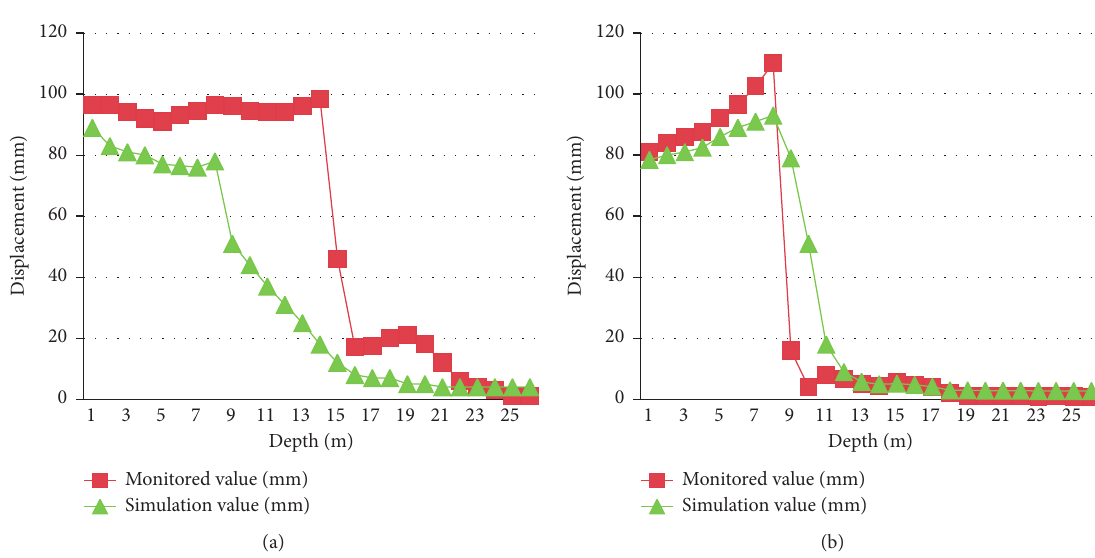
Figure 8: Actual horizontal displacement monitoring data compared to simulation data. (a) Location of hole 9 ( P � 0 . 039). (b) Location of hole 12 ( P � 0 .